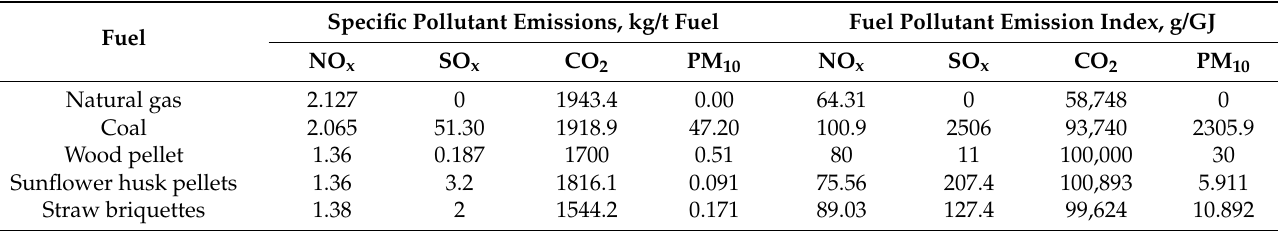
Table A1. Specific pollutant emissions from fuel combustion